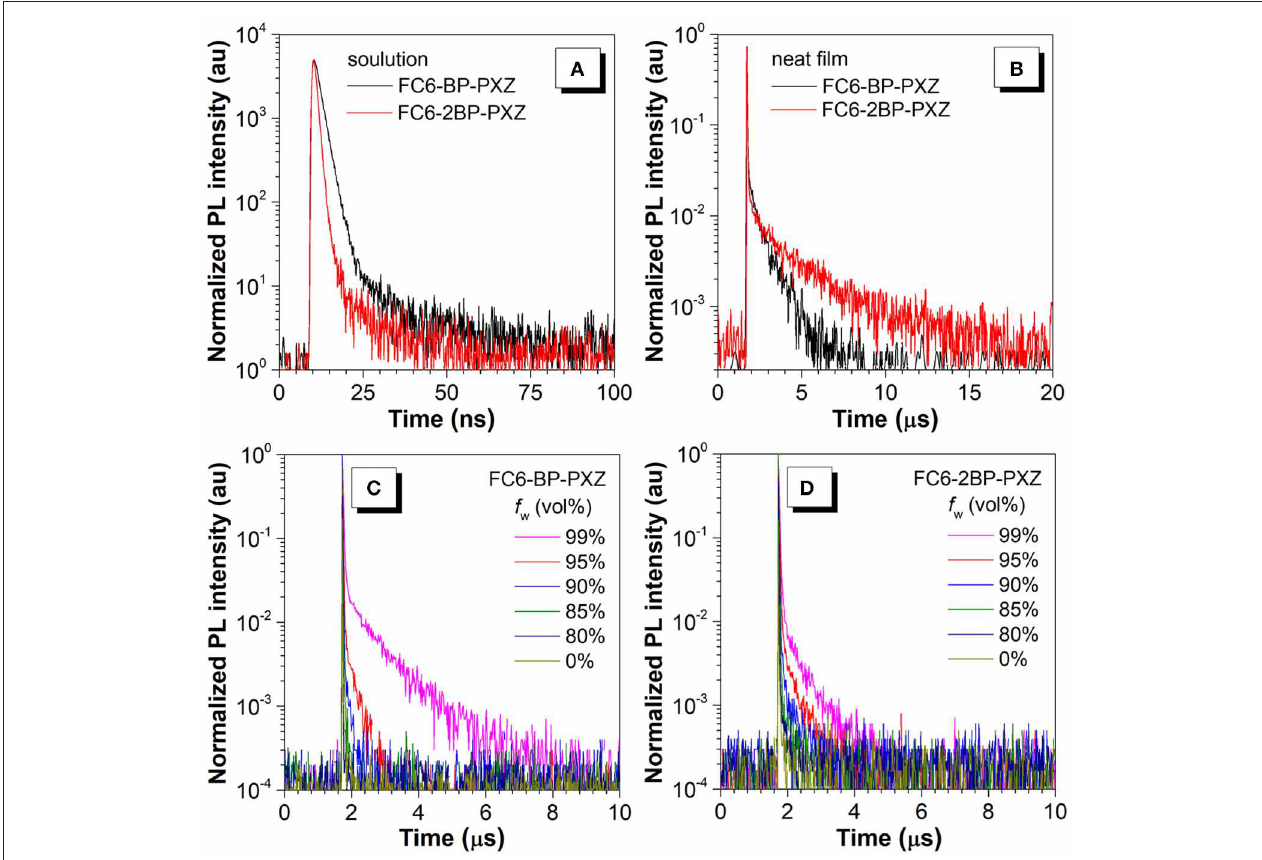
FIGURE 2 | Transient PL decay spectra of FC6-BP-PXZ and FC6-2BP-PXZ (A) in THF solutions (10 − 5 M) and (B) in neat films, measured at 300K under nitrogen. The water fraction dependent transient PL decay spectra of (C) FC6-BP-PXZ and (D) FC6-2BP-PXZ in THF-water